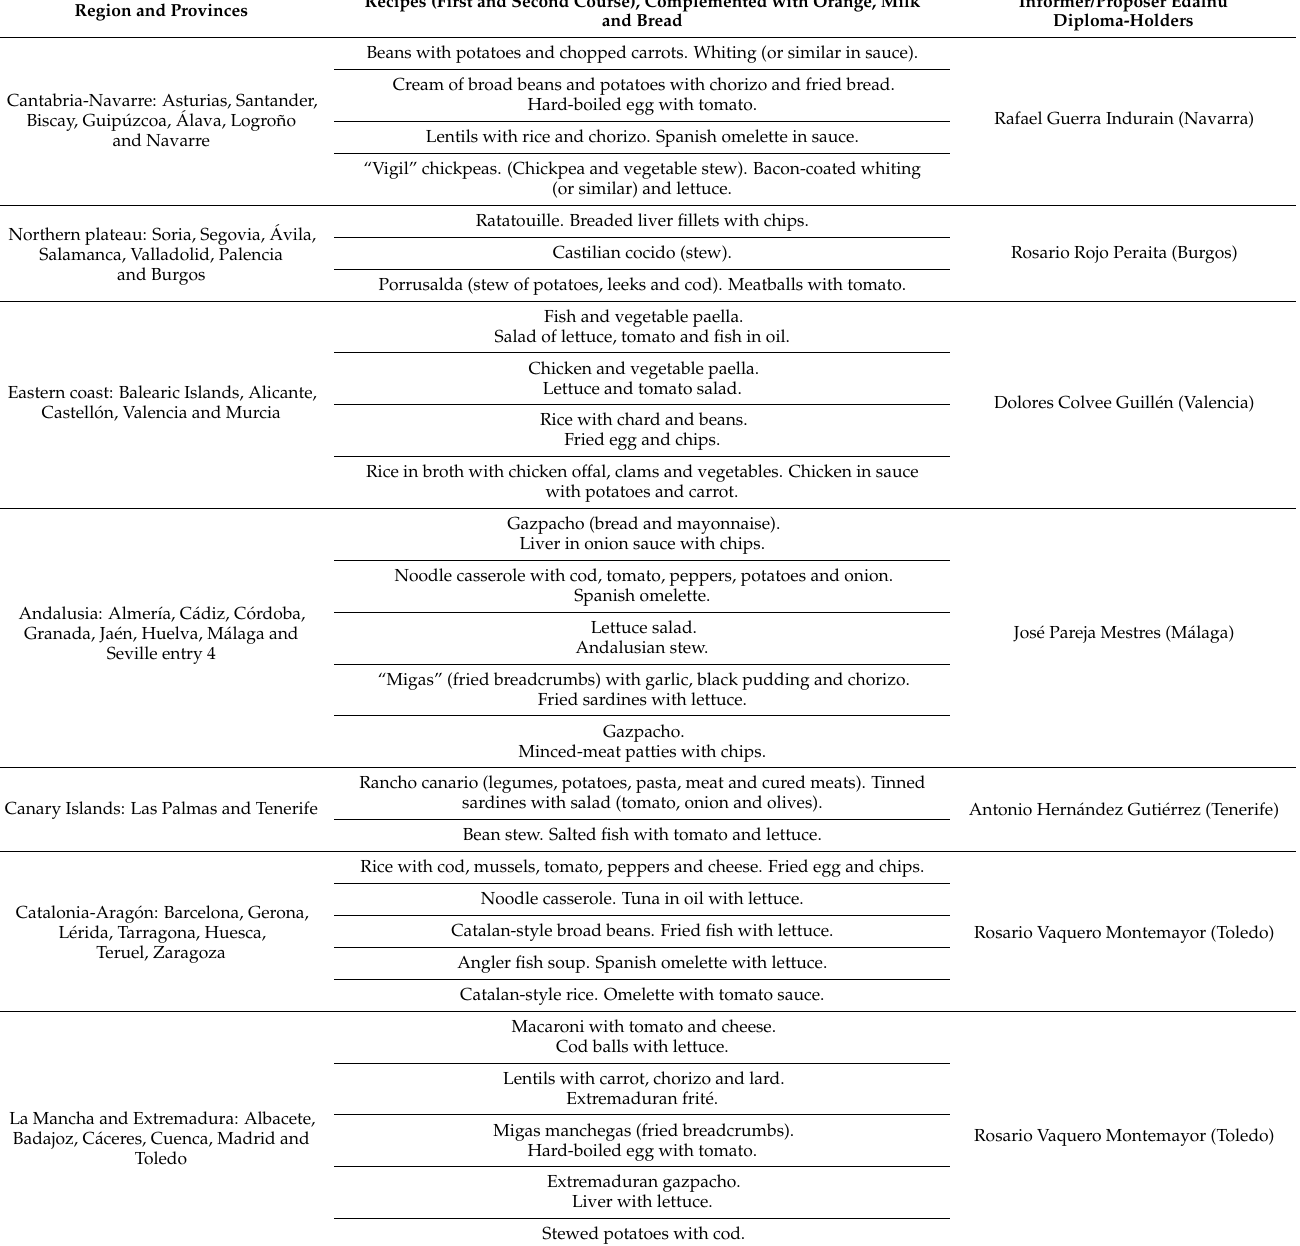
Table 2. Regional dishes for school canteens in